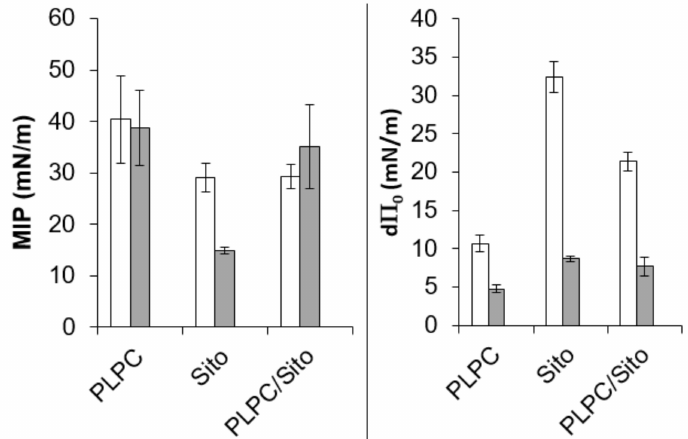
Figure 7. Adsorption of CitA (white) and CitO (grey) into lipid monolayers: PLPC, β -sitosterol or PLPC / β -sitosterol. ( A ) Maximal insertion pressure (MIP) and ( B ) di ff erential Π 0 (d Π 0 ) values. For CIN, MIP, and d Π 0 were not